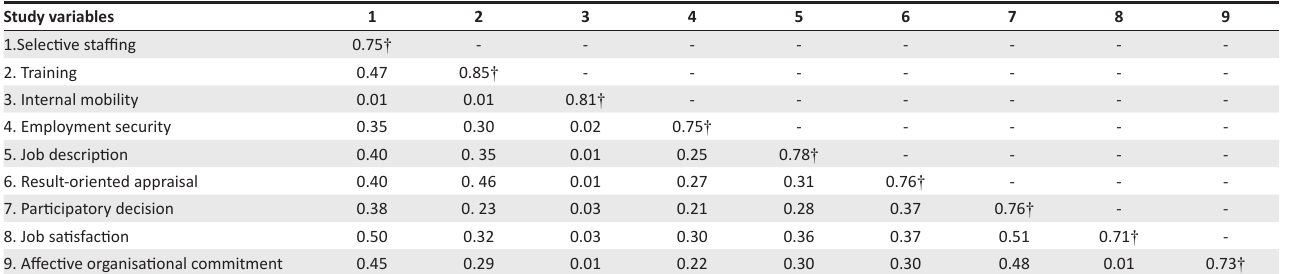
TABLE 4: Discriminant validity.